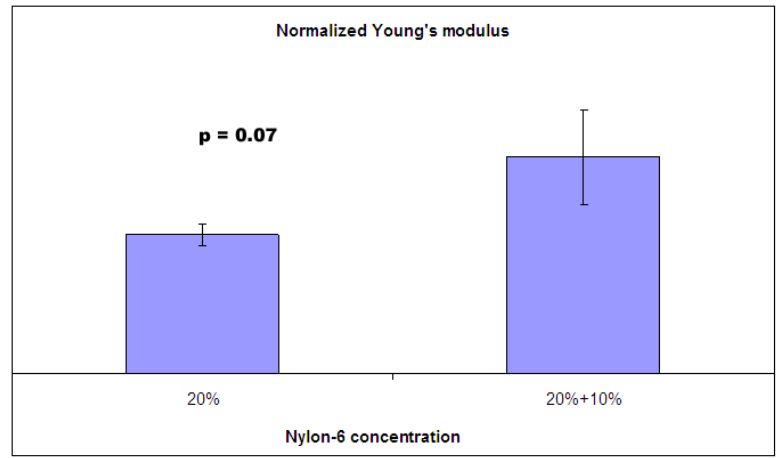
Figure 3. Beads effect on Young’s modulus of electrospun nylon 6 non-woven fiber mats.